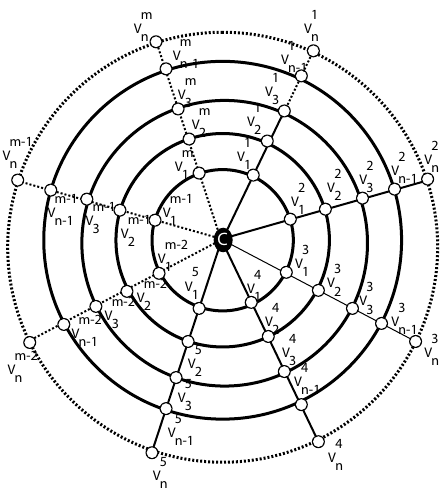
Figure 2. Polaroid Grid PG ( m , n )